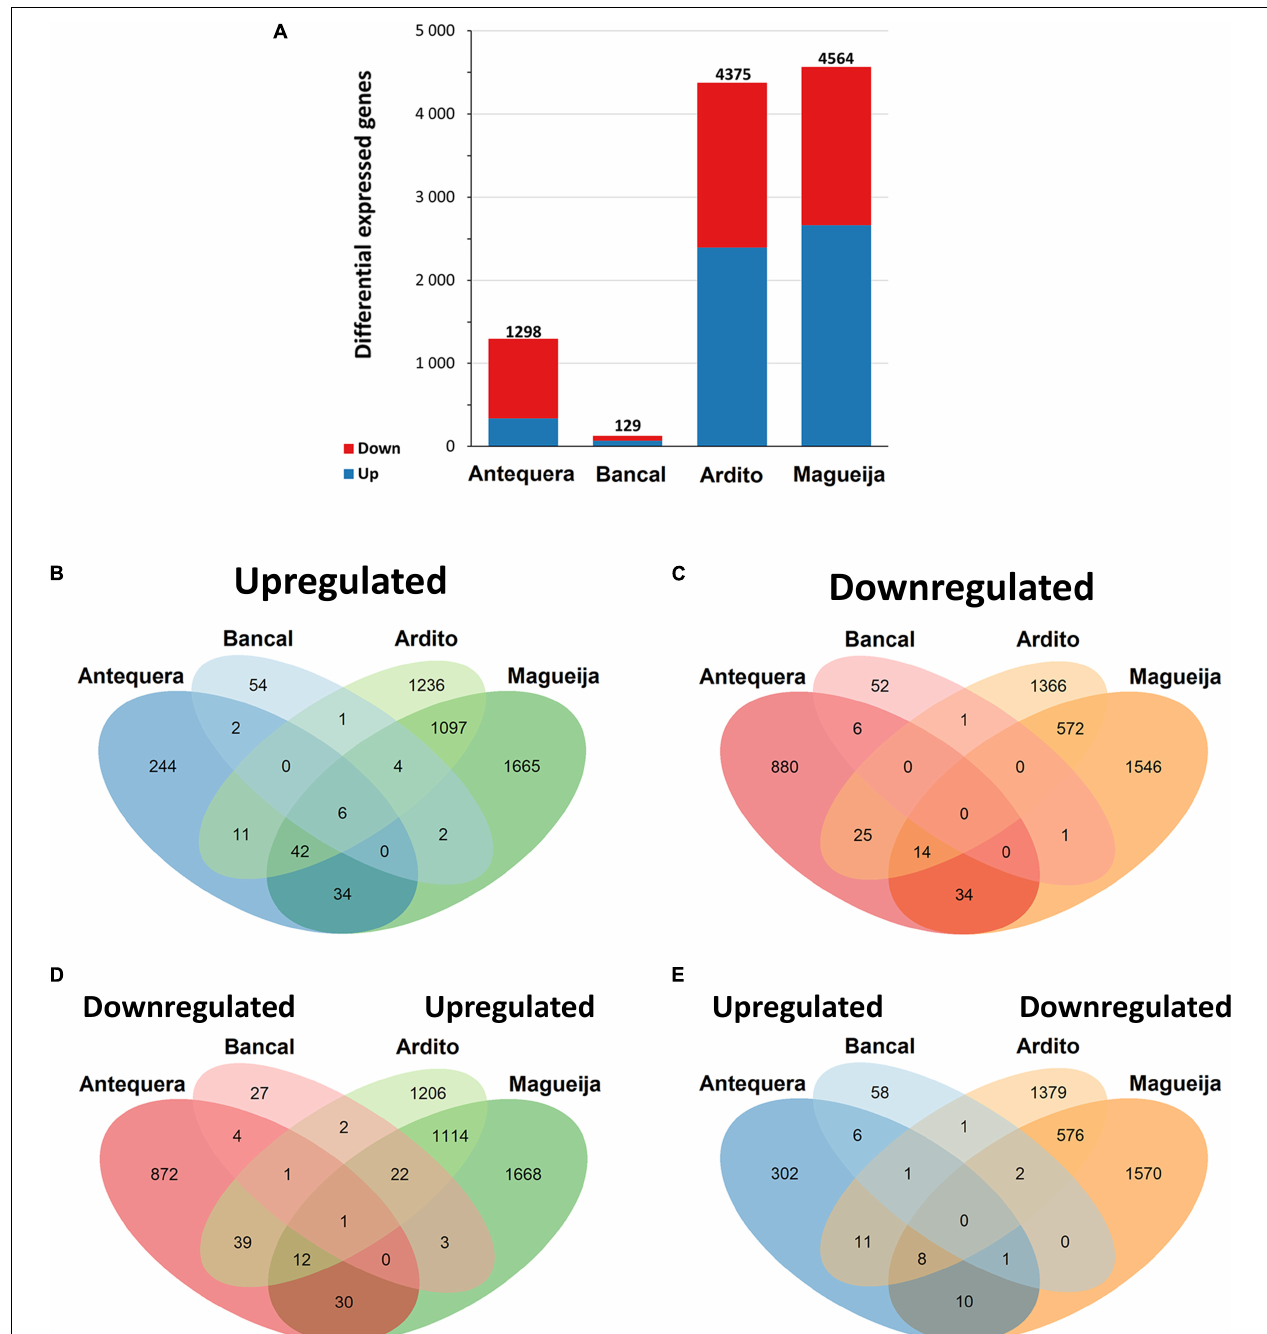
FIGURE 2 | Differentially expressed genes (DEGs). (A) Number of DEGs between control and high temperature treated samples of commercial varieties Antequera and Bancal and landraces Ardito and Magueija. Red and blue indicate down and upregulated genes, respectively. (B–E) Venn diagrams of differentially expressed genes in commercial varieties Antequera and Bancal and landraces Ardito and Magueija: (B) upregulated in all genotypes; (C) downregulated in all genotypes; (D) downregulated in commercial varieties and upregulated in landraces; (E) upregulated in commercial varieties and downregulated in landraces. Non-overlapping regions represent the number of genes exclusive to one genotype. Overlapping regions indicate the number of genes common to two, three or four